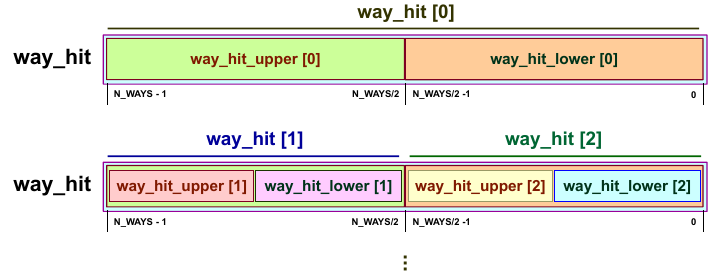
Figure 6. Computing way_hit slices.